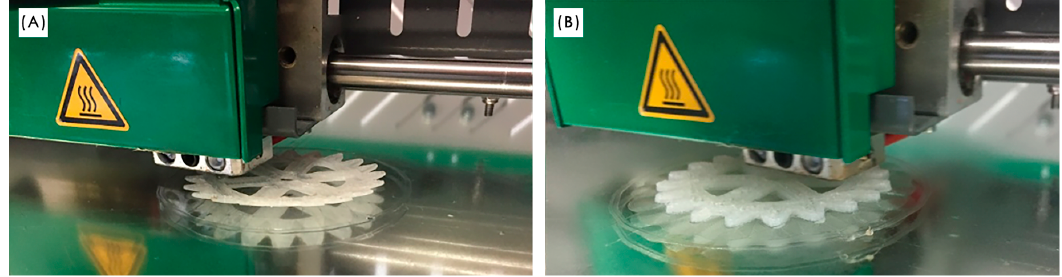
Figure 5. Printing of a PA12 part with ( A ) a skirt leads to detachment from the build platform; ( B ) printing with a brim leads to completion of the printing job [57].